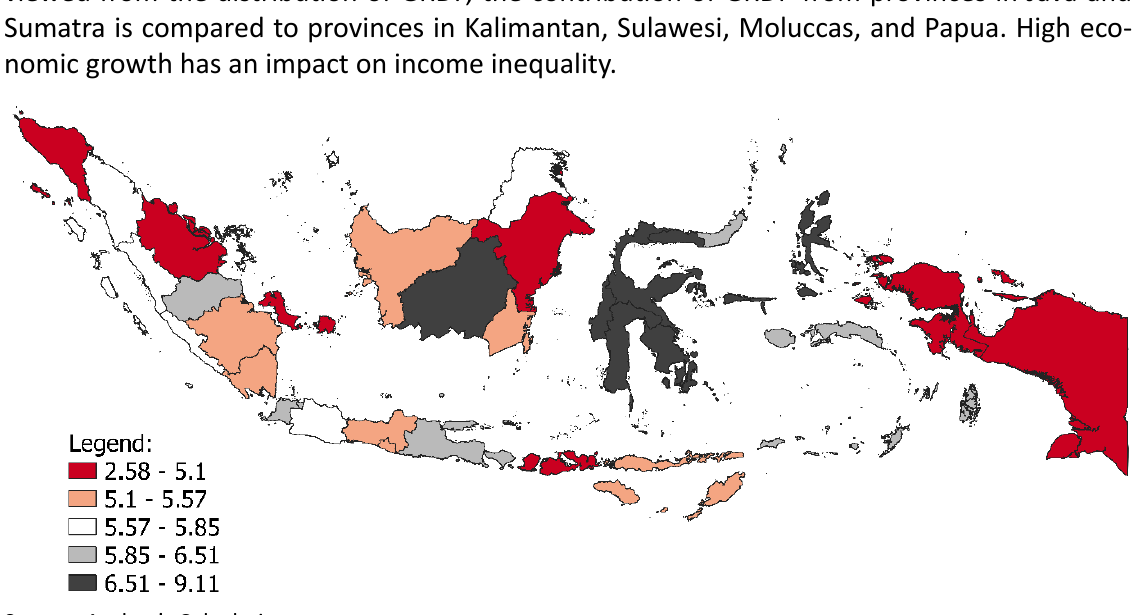
Figure 4: The Average Distribution of Economic Growth in 34 Provinces in Indonesia, 2010- 2018